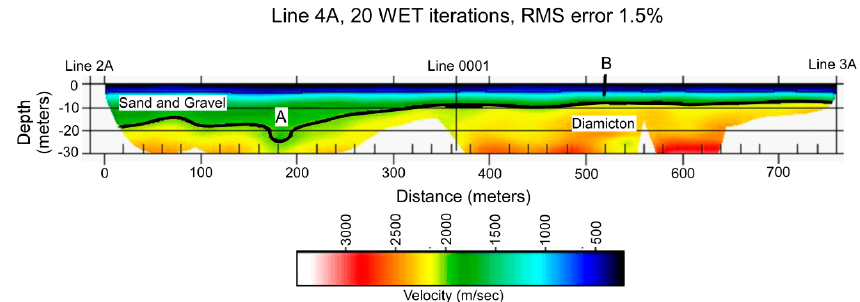
Figure 12. Seismic velocity profile of Line 4A, east is to the right. A = deepest part of the channel; B = the terrace elevation.